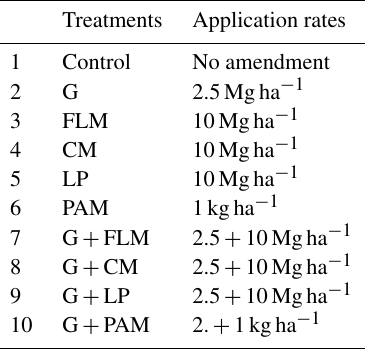
Table 3. Treatments and their application